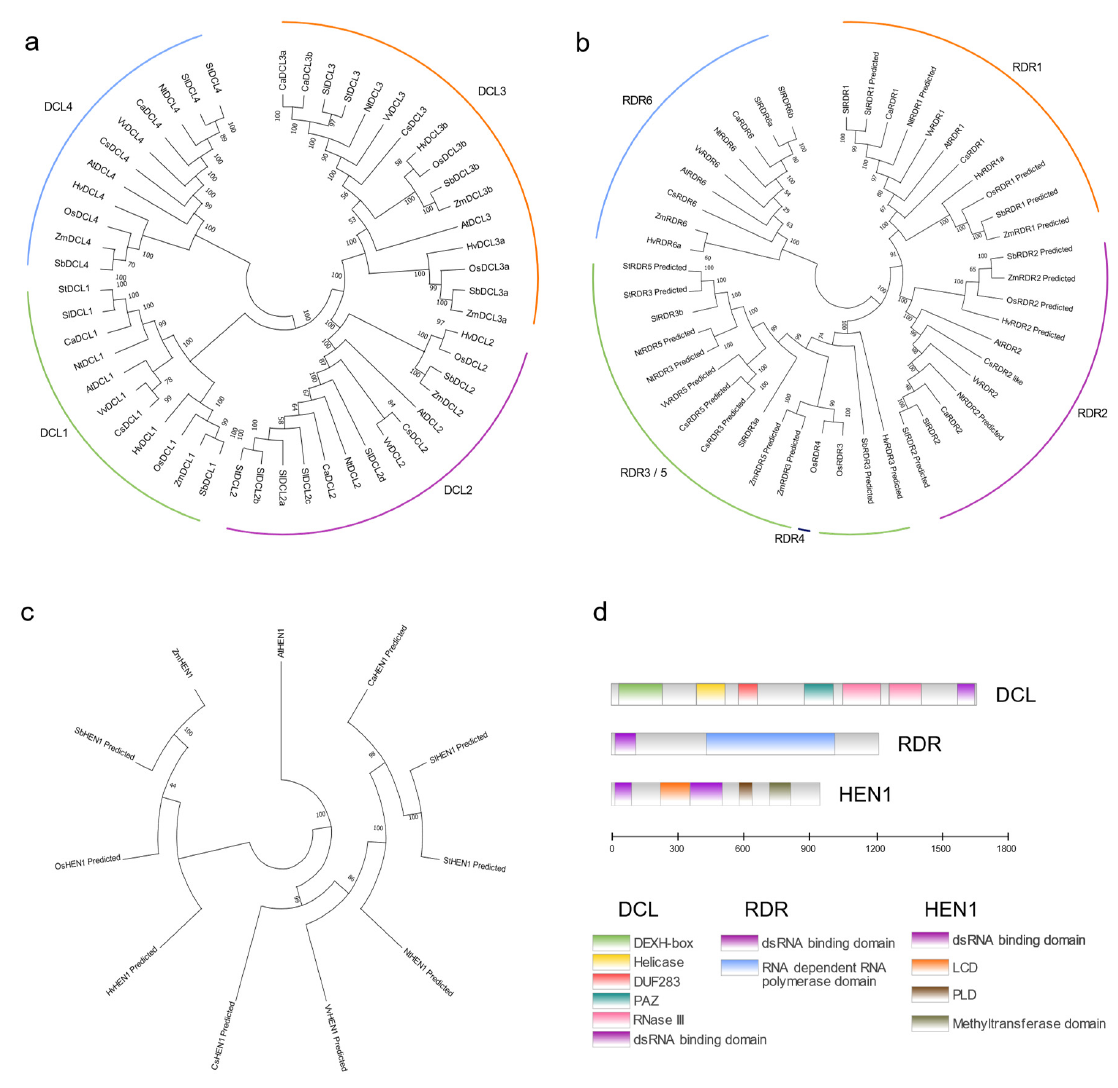
Figure 1. Core components involved in small RNAs biogenesis. ( a ), ( b ), ( c ) Phylogenetic tree based on the alignment of protein sequences of DCLs, RDRs and HEN1 from eleven plant species. ( d ) Schematic representation of the conserved domains in plant DCLs, RDRs and HEN1. The proteins that haven’t been accurately identified are marked with “predicted” after their names. Protein se-